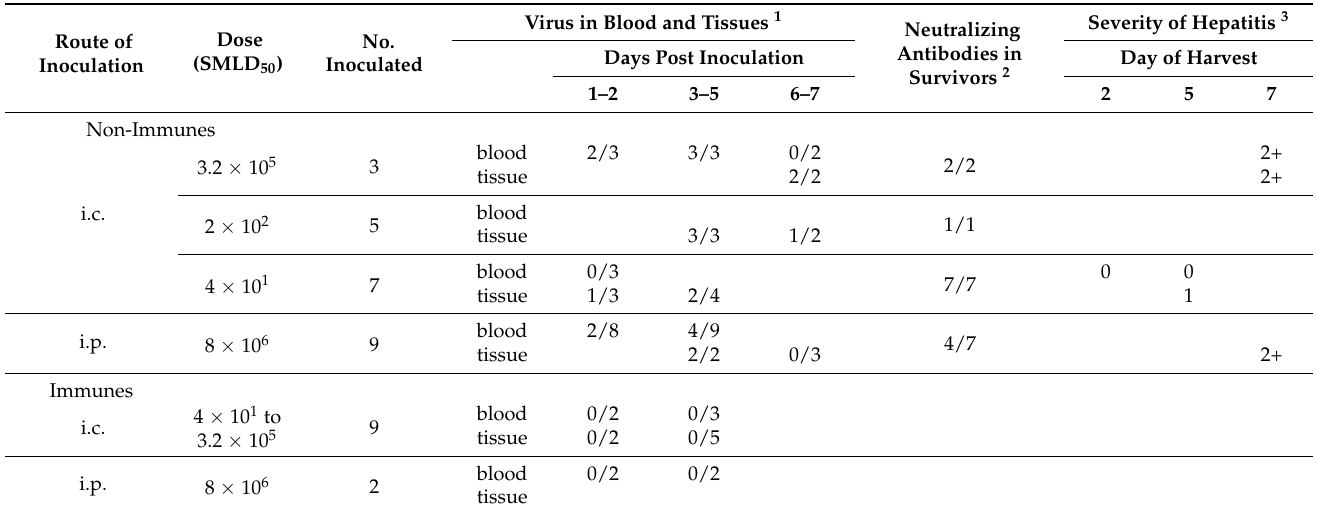
Table 9. Hepatitis and viral isolations from laboratory-infected free-tailed